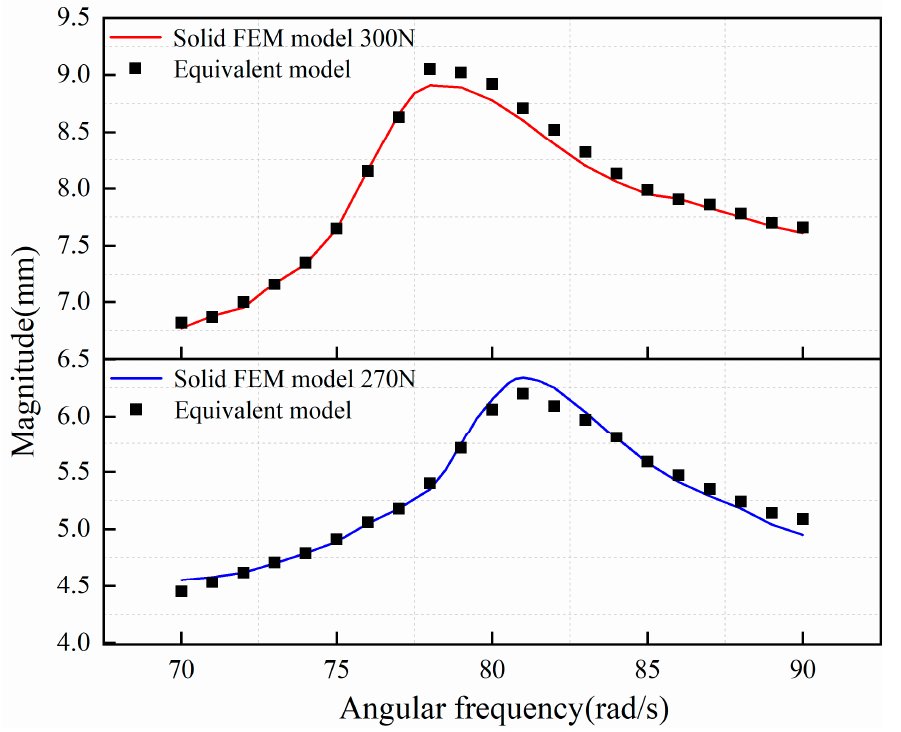
Figure 19. Amplitude–frequency responses of the equivalent model and the solid FEM model.